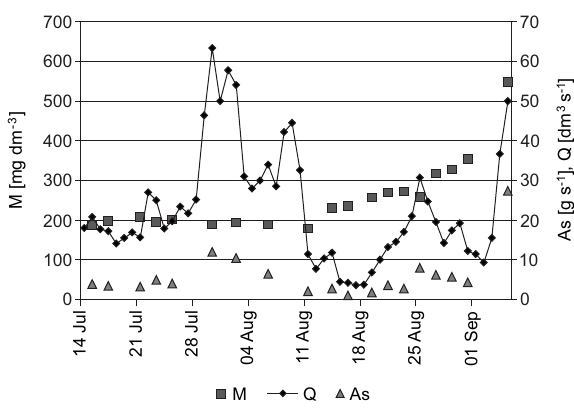
Fig. 9. Water mineralization (M) and ionic transport (As) in the stream leaving the CT-2 study catchment in relation to flow (Q) in the period 14.07–5.09.2004